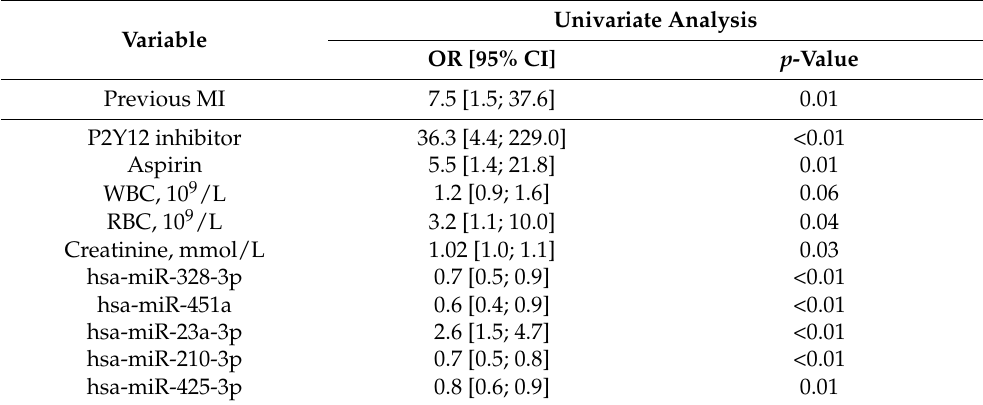
Table 4. The univariate logistic regression analysis of clinical variables and miRNA expression profile in Group 1 compared to Group 3.